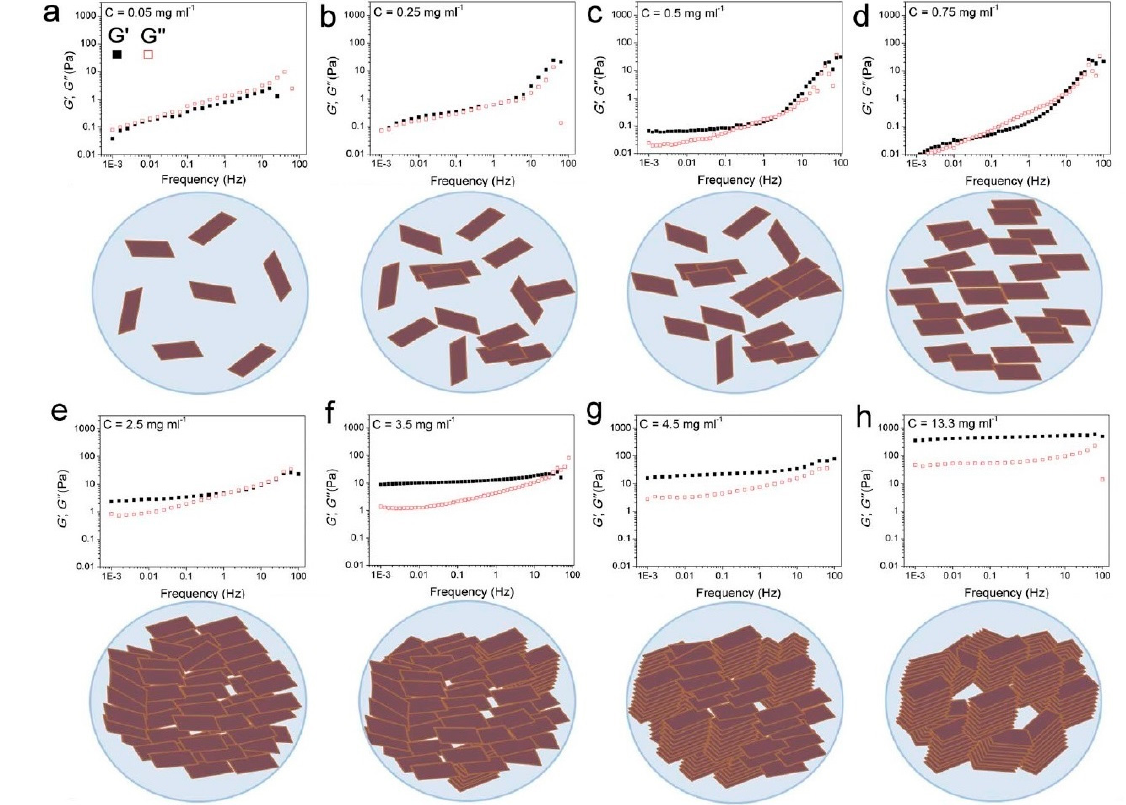
Figure 15. Storage (filled squares) and loss moduli (open squares) of graphene oxide suspensions and the schematic illustrations of the liquid crystal (LC) phase changes upon the increasing concentration of the graphene oxide suspensions. ( a ) At extremely low concentration. ( b ) and ( c ) Some nematic ordering begins to appear when the concentration increases to 0.25 mg/mL. ( d ) In the dispersion single-phase nematic LC starts to form. ( e ) The increase of the nematic phase packing is higher with the increase of the GO concentration. ( f ) Some regions of GO exhibit orientation in the nematic phase. ( g ) and ( h ) Smaller monodomains are formed associated with an exceptional increase in elastic modulus. Adapted from [204], with permission from The Royal Society of Chemistry, 2014.